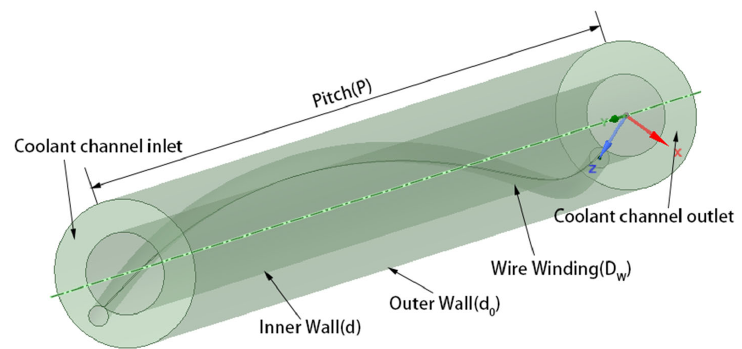
Figure 19. Physical model for numerical simulation of Chen et al. [19]. Table 10. Boundary conditions for the numerical simulation of Chen et al. [19].